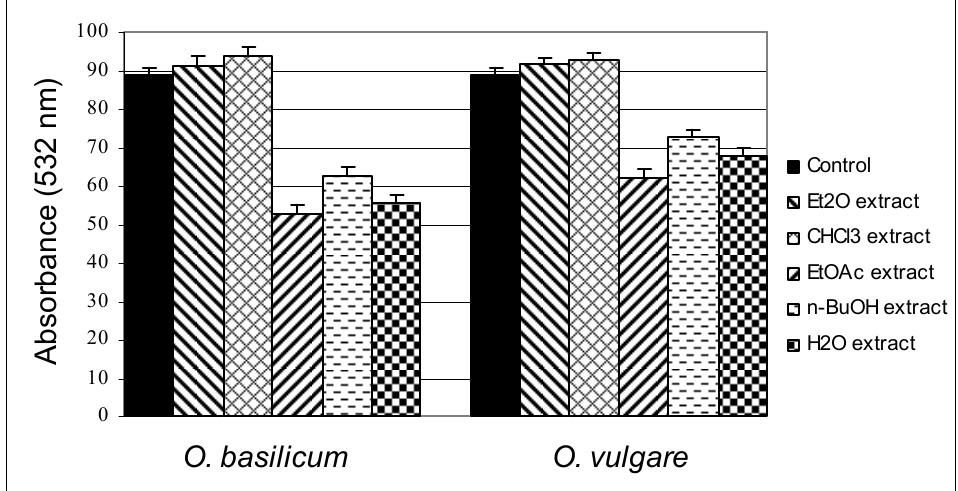
Figure 2. Inhibition of LP in Fe 2+ /ascorbate system of induction by different extracts of O. basilicum and O. vulgare in the TBA